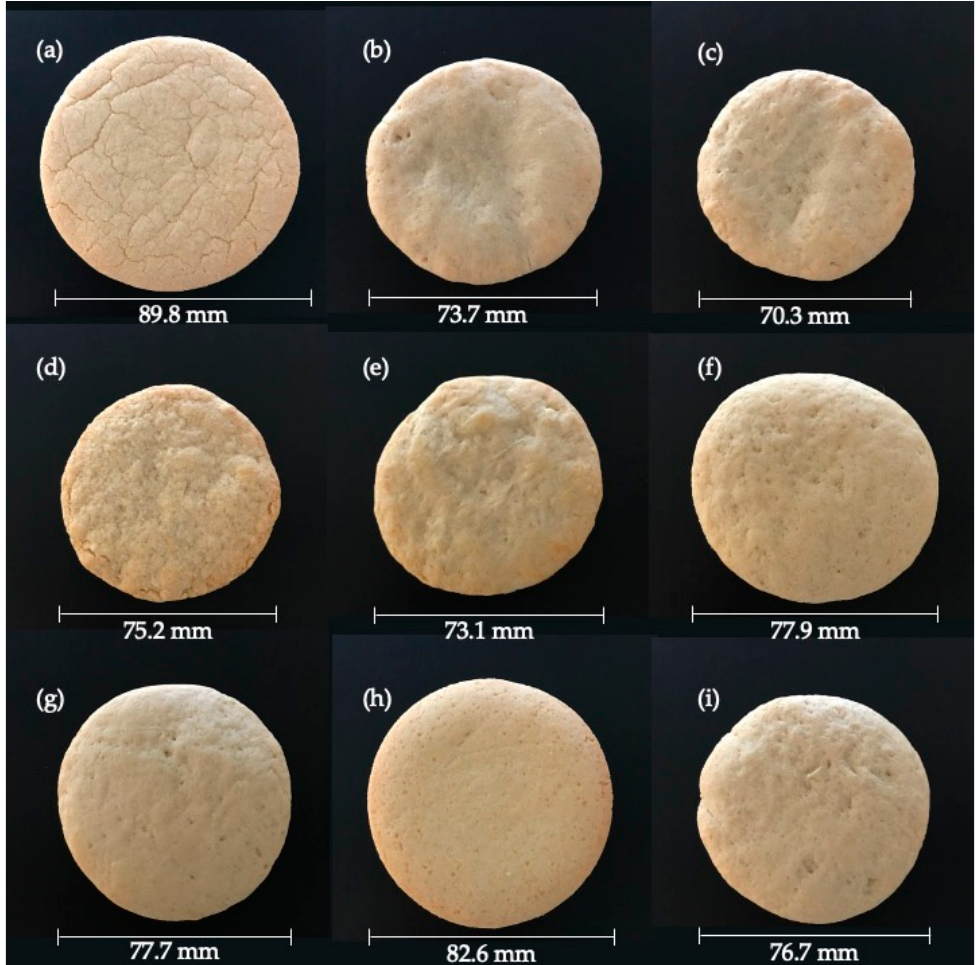
Figure 1. Top images of cookies from each treatment: control ( a ), Splenda for baking ( b ), Equal for baking ( c ), Truvia ( d ), Sweet’N Low ( e ), Splenda + sucrose ( f ), Equal + sucrose ( g ), Truvia + sucrose ( h ), Sweet’N Low + sucrose ( i ).